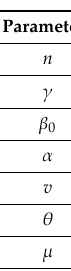
Table 2. Parameter setting of immune firefly algorithm (IFA) algorithm.